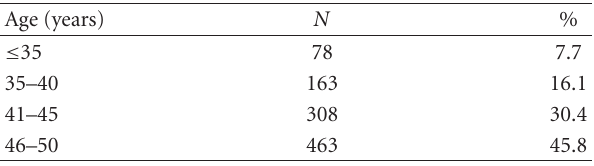
Table 1: Age distribution at the time of study